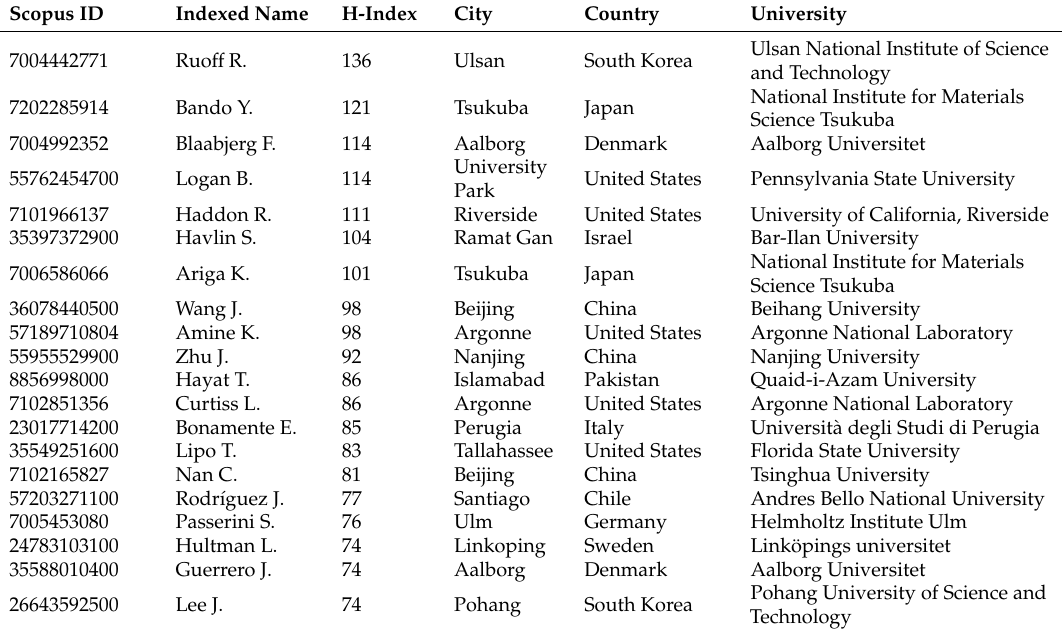
Table 2. Distribution of the authors according to the